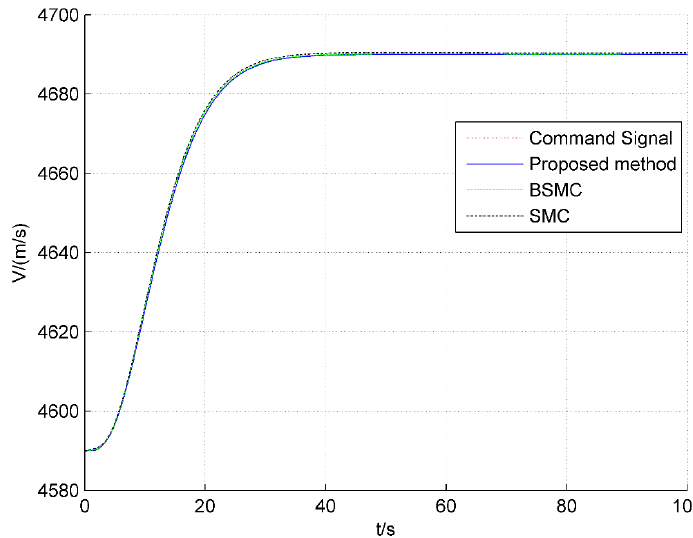
Figure 4. Responses of velocity tracking.